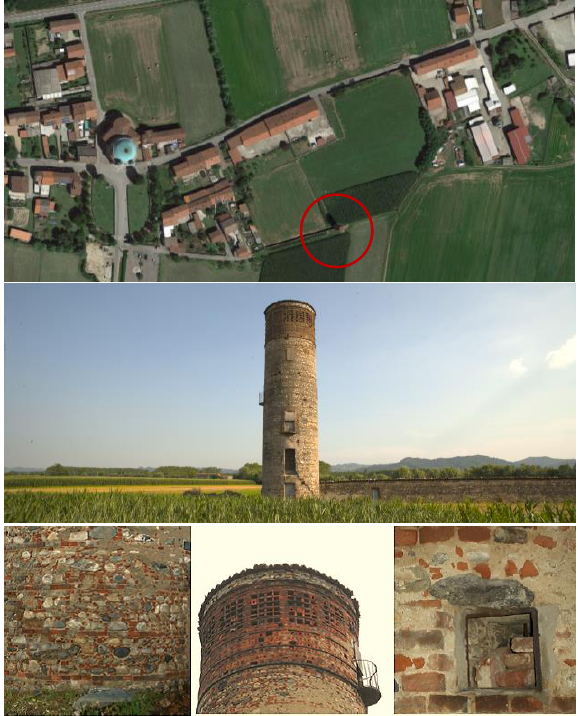
Figure 1. The late-medieval tower. Satellite image by Google © . Details on the dovecot and on mixed stone and brick masonry.